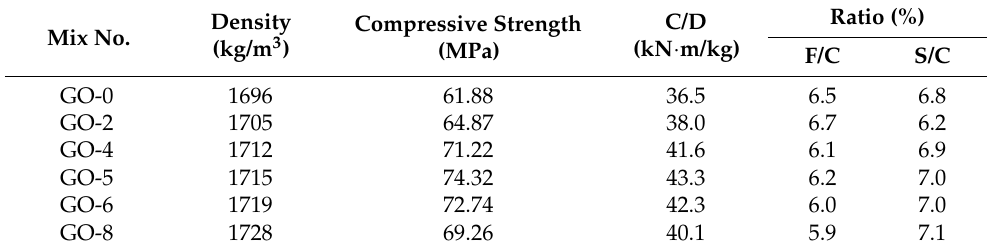
Table 4. The results and analysis of density and mechanical properties.